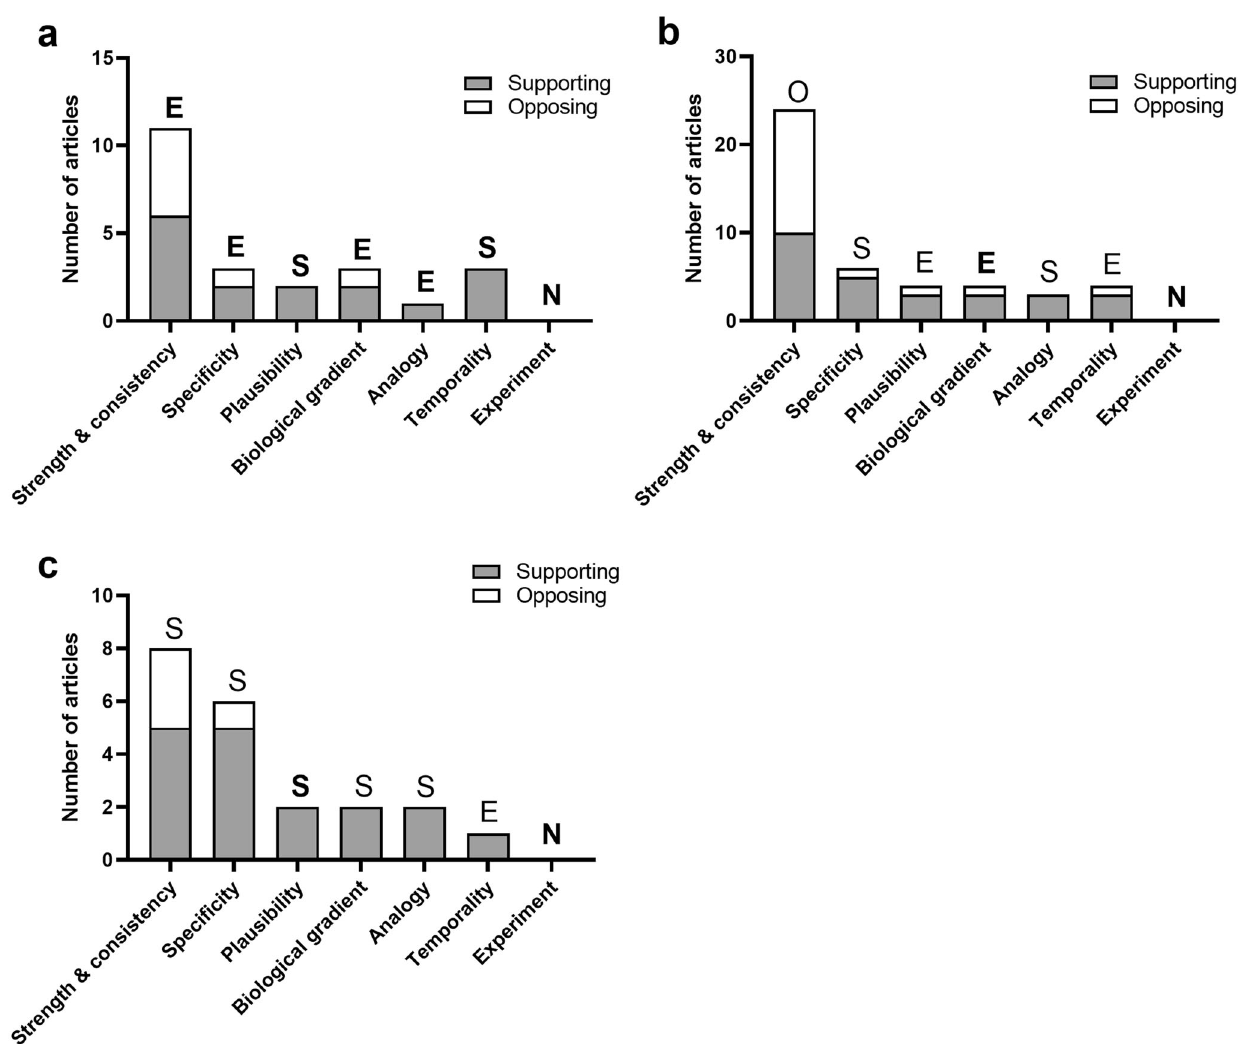
Fig. 3 Bradford Hill criteria data and outcomes of all included articles investigating alterations in SN copper levels, or levels of cuproproteins or copper-associated genes in Parkinson ’ s disease. a Portrays results obtained from high quality articles alone, whereas b depicts the combined results from high and moderate quality articles. c All articles reporting alterations in copper metal levels in the Parkinson ’ s disease SN or SNc, that is, excluding articles reporting protein and/or genetic changes. Data for the Bradford Hill criterion, coherence, is considerably higher than other criteria and was therefore presented in Supplementary Table 3. Letters S (supporting), O (opposing), and E (equivocal) indicate overall criteria outcomes determined by analyses of all included studies. Non-bolded letters highlight discrepant criteria outcomes between each panel and ( a ). N, no